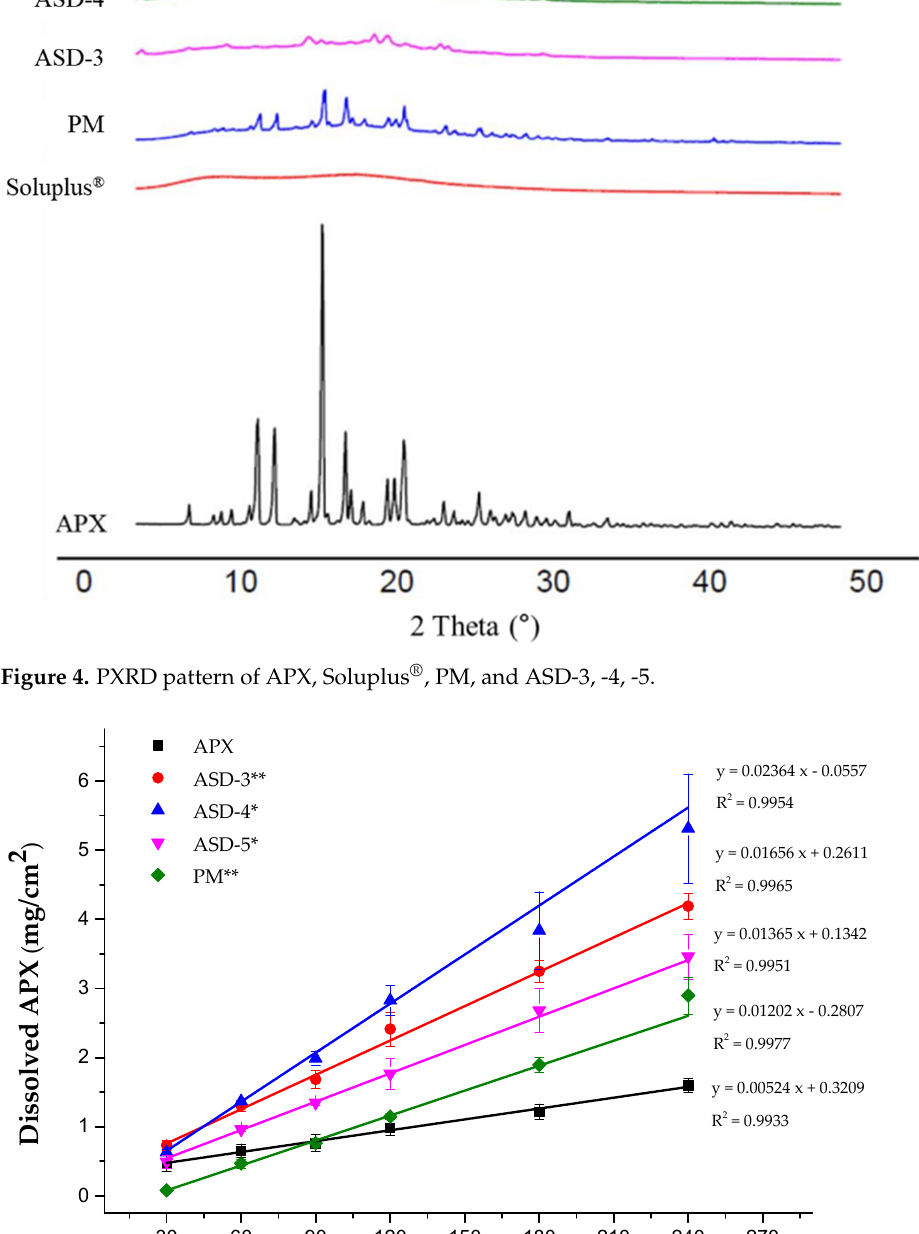
Figure 5. DIDR profiles of APX, ASD-3, ASD-4, ASD-5 and PM. * p < 0.05, ** p <